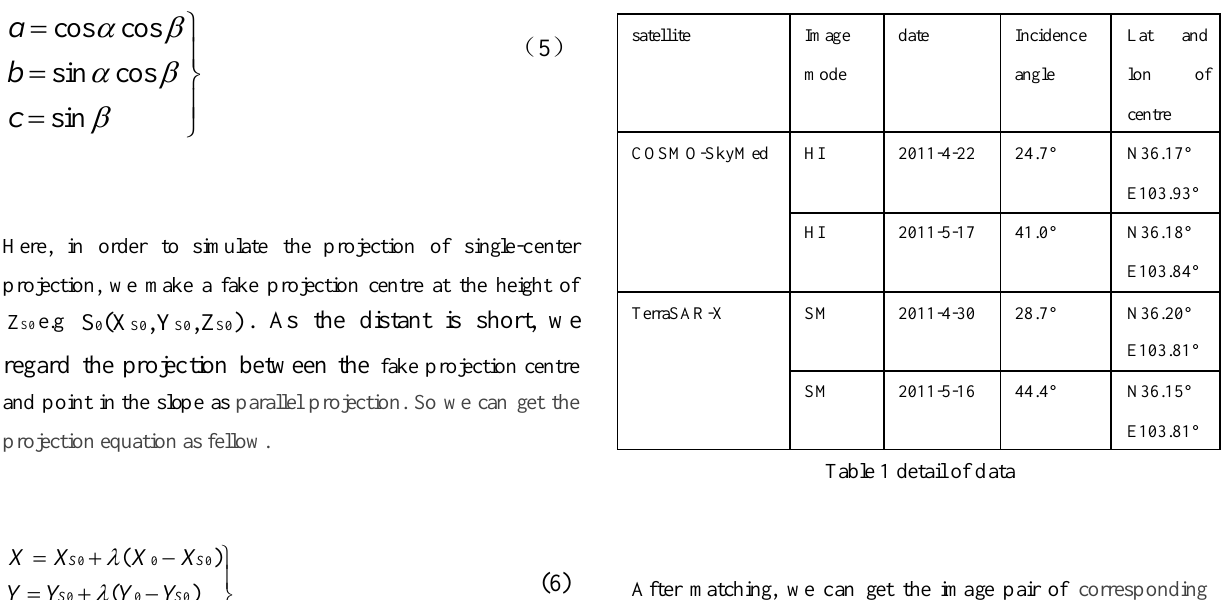
After matching, we can get the image pair of corresponding image